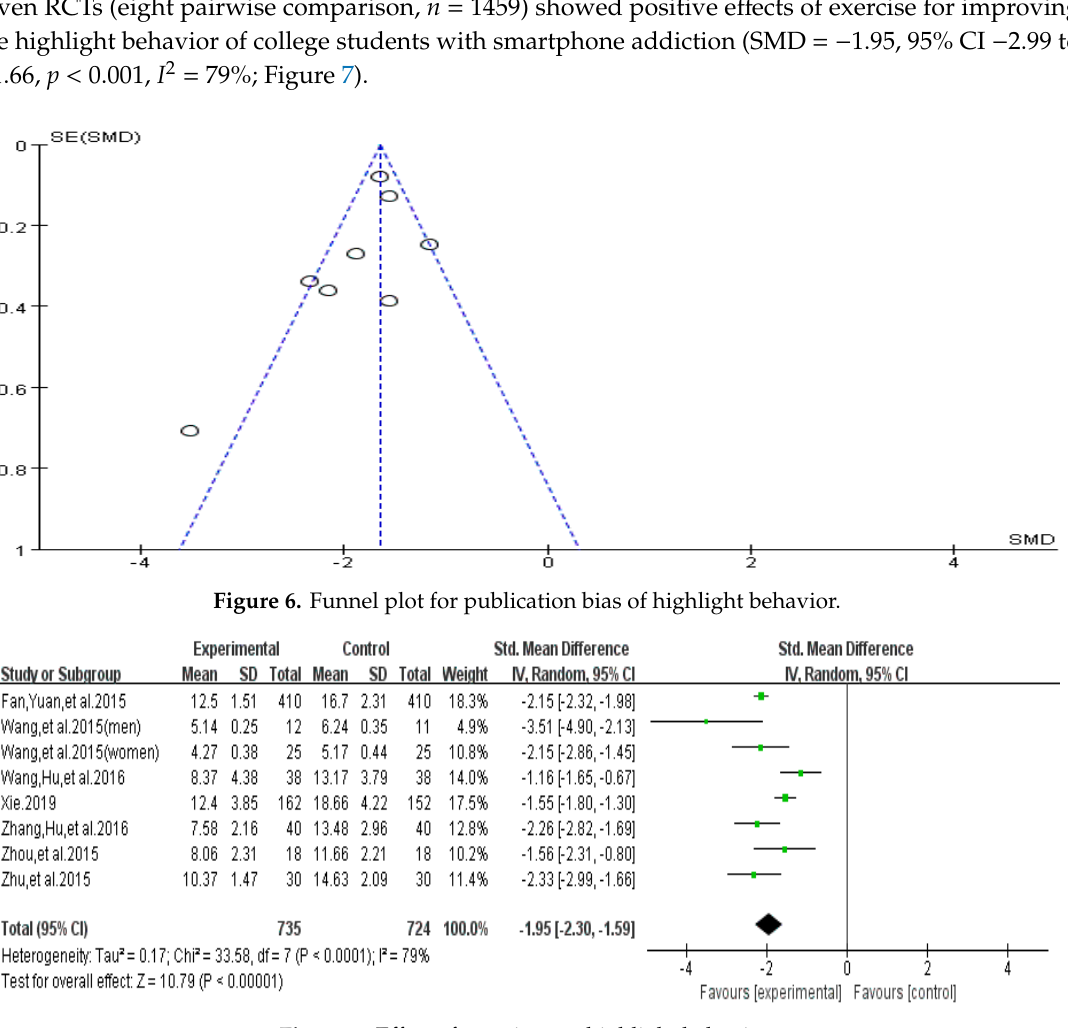
Figure 7. E ff ect of exercises on highlight Figure 7. Effect of exercises on highlight behavior. Figure 7. Effect of exercises on highlight behavior.